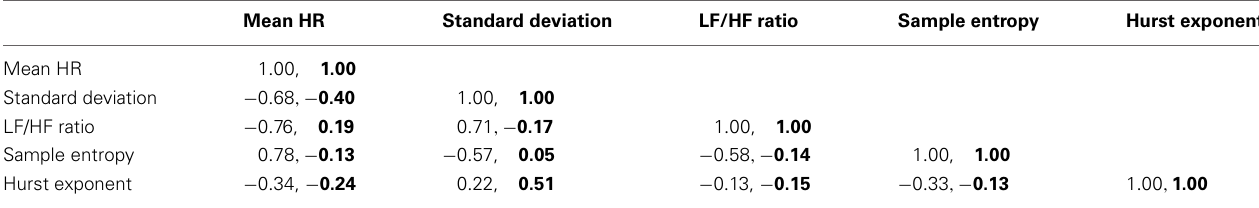
Table 4 | Spearman correlation matrix of the population trends in EXERCISE and SEPSIS, during